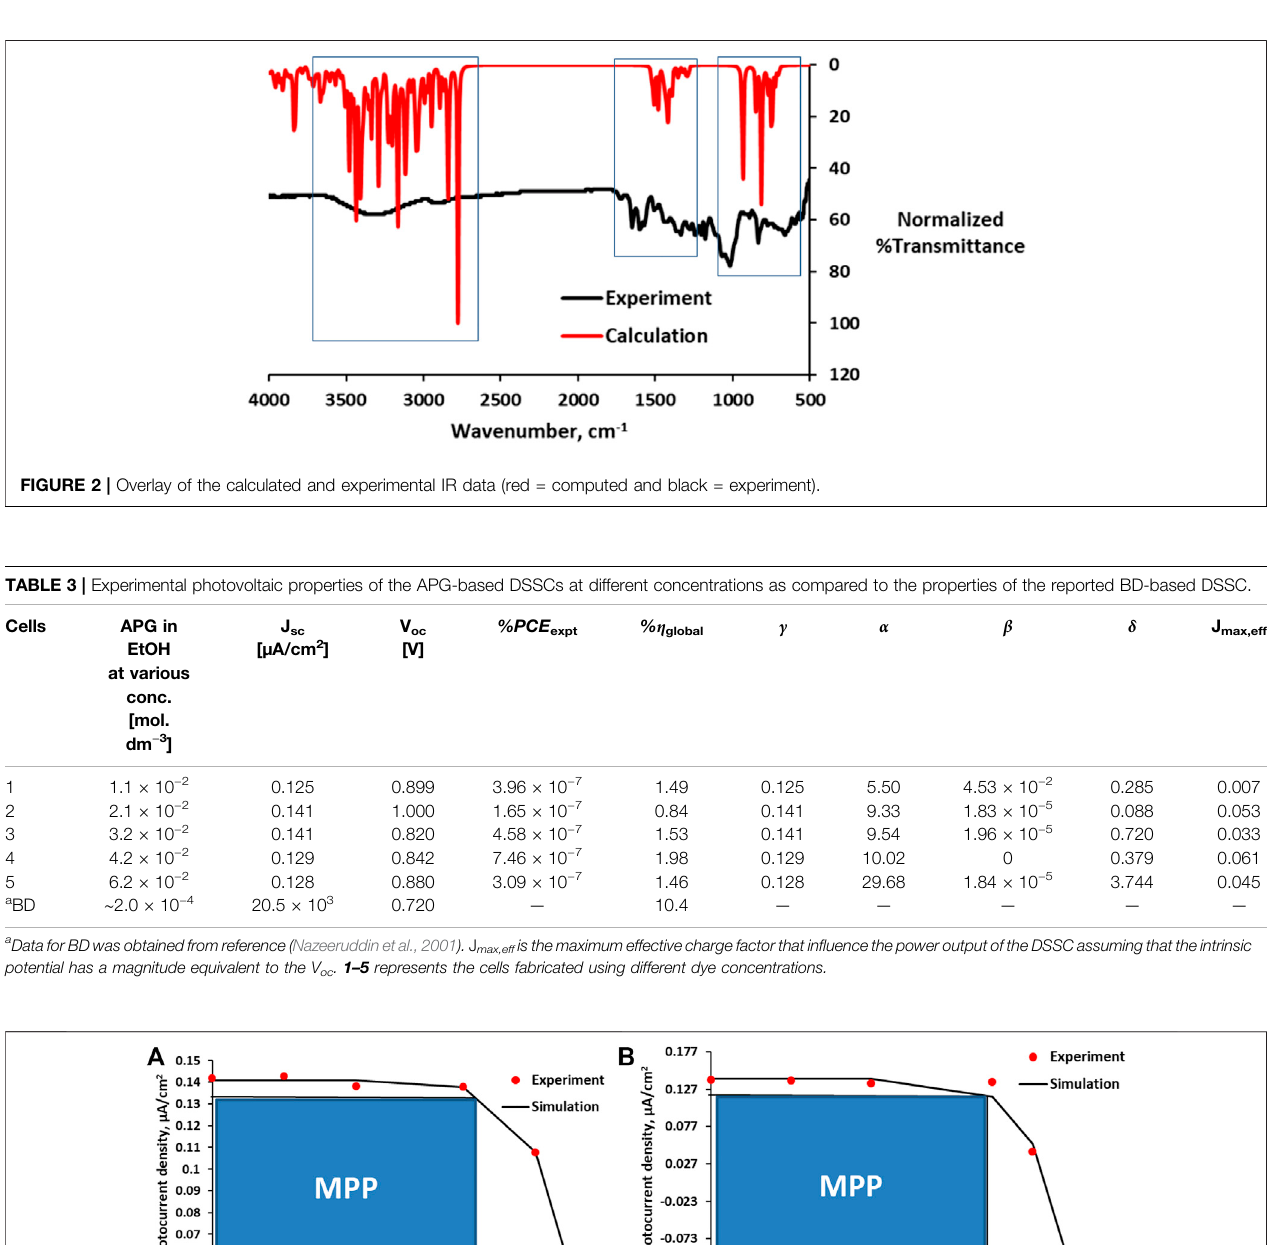
FIGURE3| I-Vpro fi les(experimentalandsimulated)forcell2 (A) andcell3 (B) asrepresentatives(MPP,maximumpowerpoint).Thesolidlinerepresentsthe fi tting curve obtained with Eq. 1 .